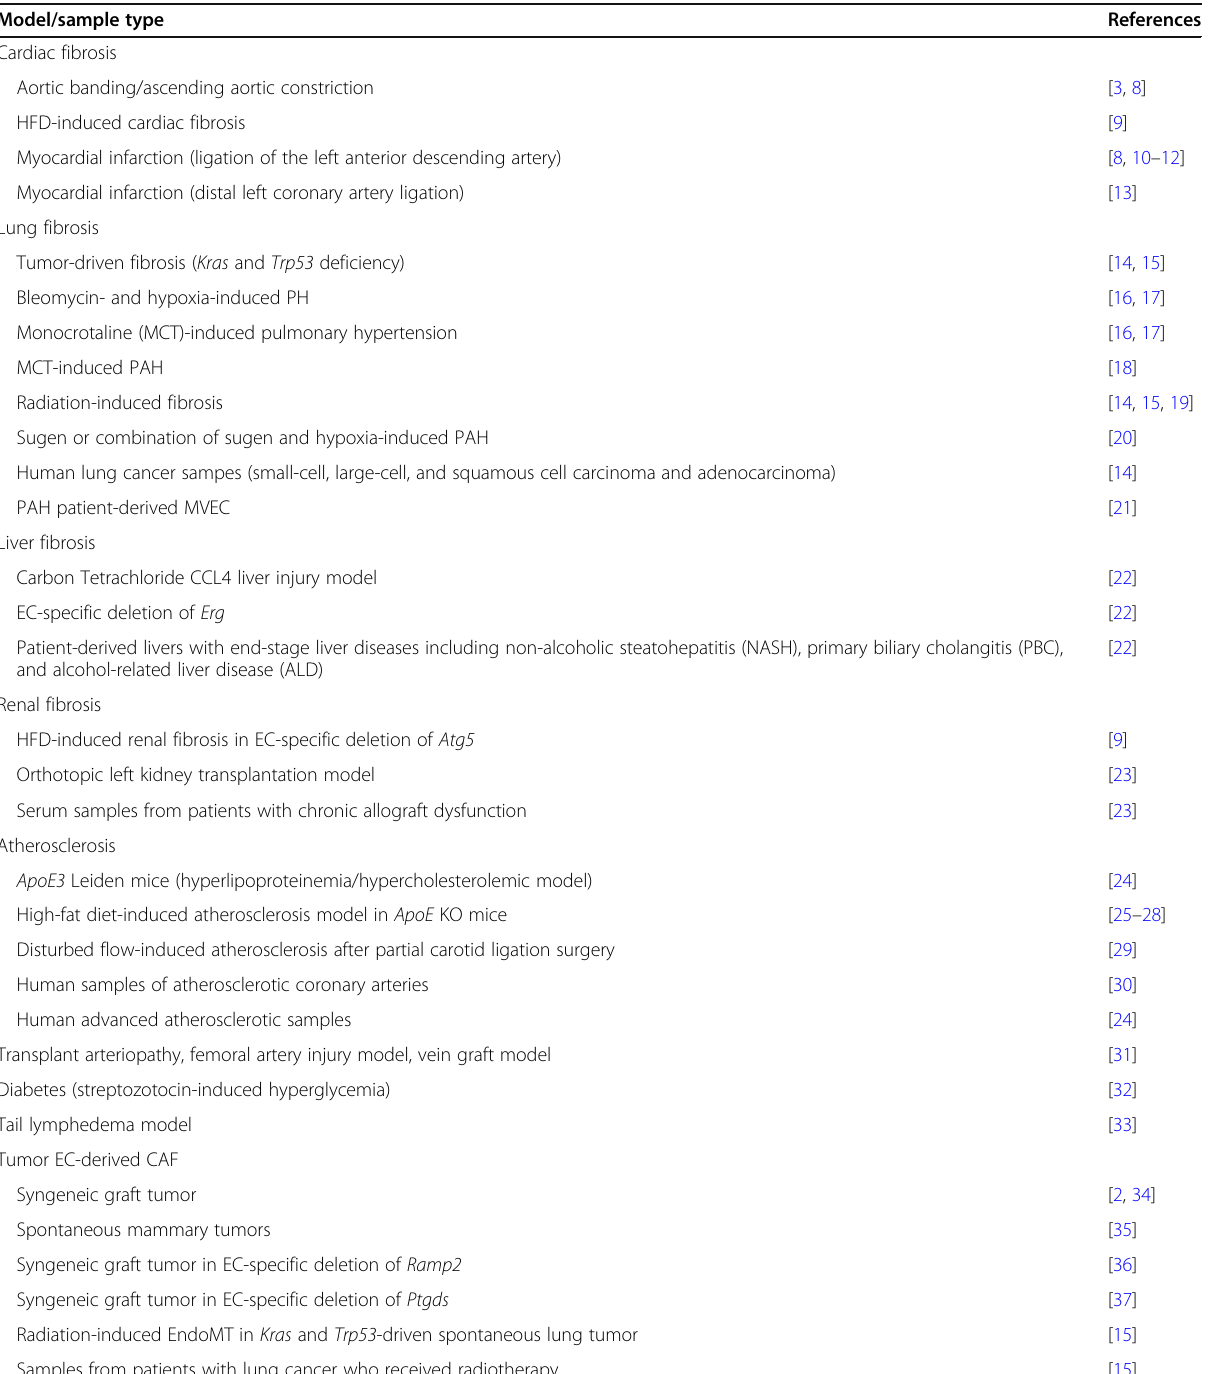
Table 2 Mouse/rat models or human samples used in the studies introduced in this review Model/sample